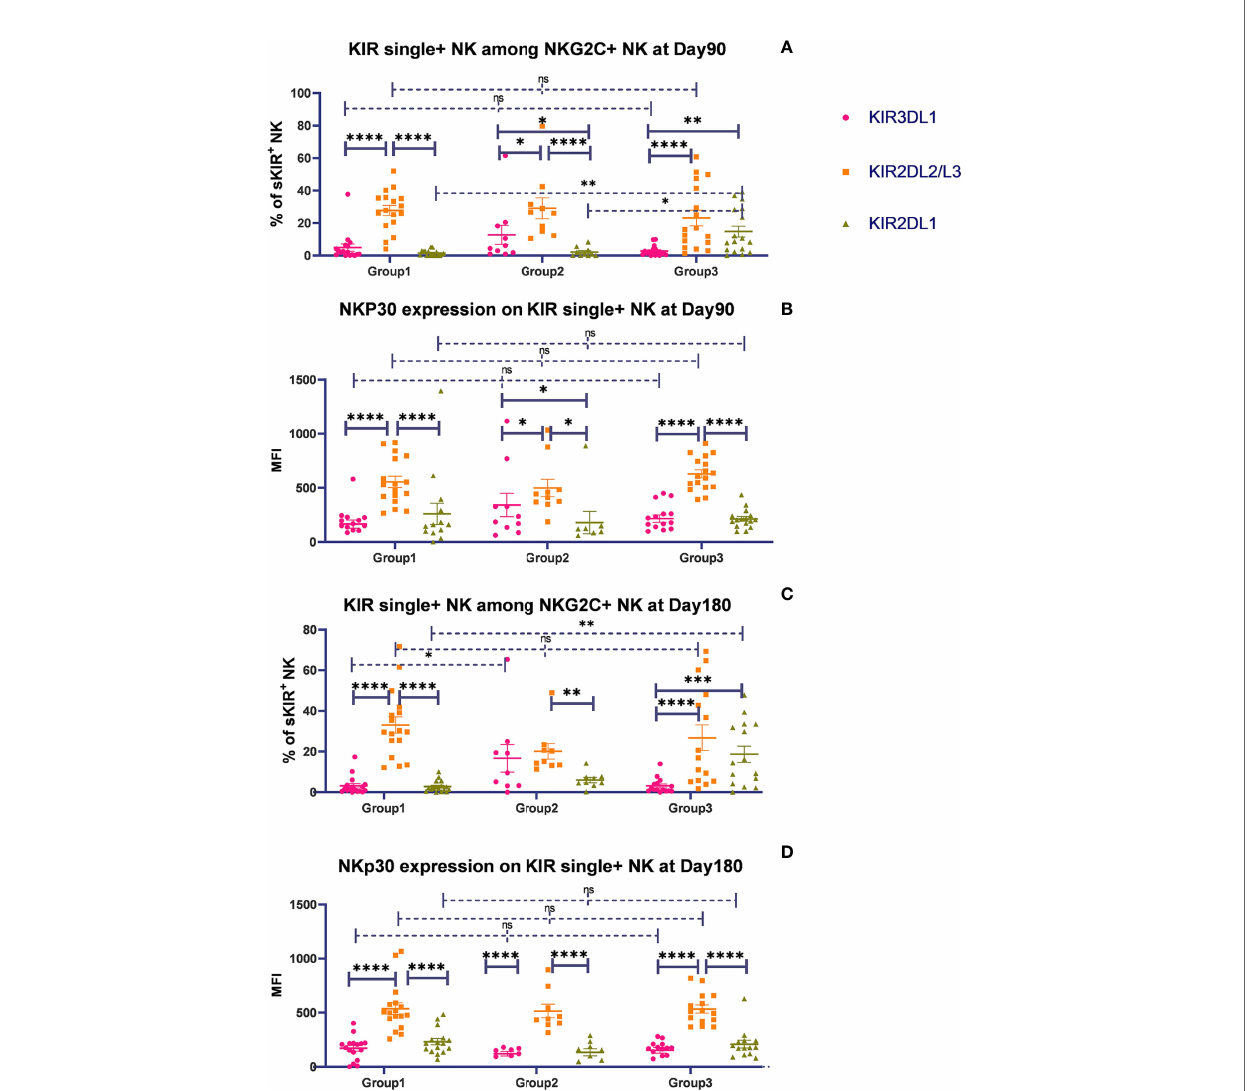
FIGURE 2 | The presence of HLA-C1 enhanced the expansion of KIR2DL2/3 single-positive NKG2C + NK cells and the expression of NKp30. The surface markers of peripheral blood mononuclear cells (PBMCs) from patients ’ fresh blood sample were analyzed by fl ow cytometry, performed in PBS at 4°C for 30 min following Fc blockade. (A, C) The proportion of KIR2DL1, KIR2DL2/L3, and KIR3DL1 single-positive NKG2C + /NKG2A - /CD56 + NK cells from patients after HSCT in group 1 (recipient donor C1C1; day 90, n = 17; day 180, n = 17), group 2 (recipient donor C1BW4; day 90, n = 10; day 180, n = 9), and group 3 (recipient donor C1C2BW4; day 90, n = 17; day 180, n = 15), with the presence of their respective ligands. (B, D) The mean fl uorescence intensity (MFI) of NKp30 on KIR2DL1, KIR2DL2/L3, and KIR3DL1 single-positive NKG2C + /NKG2A - /CD56 + NK cells from patients after HSCT in group 1 (day 90, n = 17; day 180, n = 17), group 2 (day 90, n = 10; day 180, n = 9), and group 3 (day 90, n = 17; day 180, n = 15). Each plot (triangle, circle, or square) represents one patient with the indicated receptor expression. The middle horizontal lines show the mean values for each group, and the upper and lower horizontal lines show the standard error of the mean. * p < 0.05; ** p < 0.01; *** p < 0.001; **** p < 0.0001; n.s., not signi fi cant (Kruskal – Wallis H